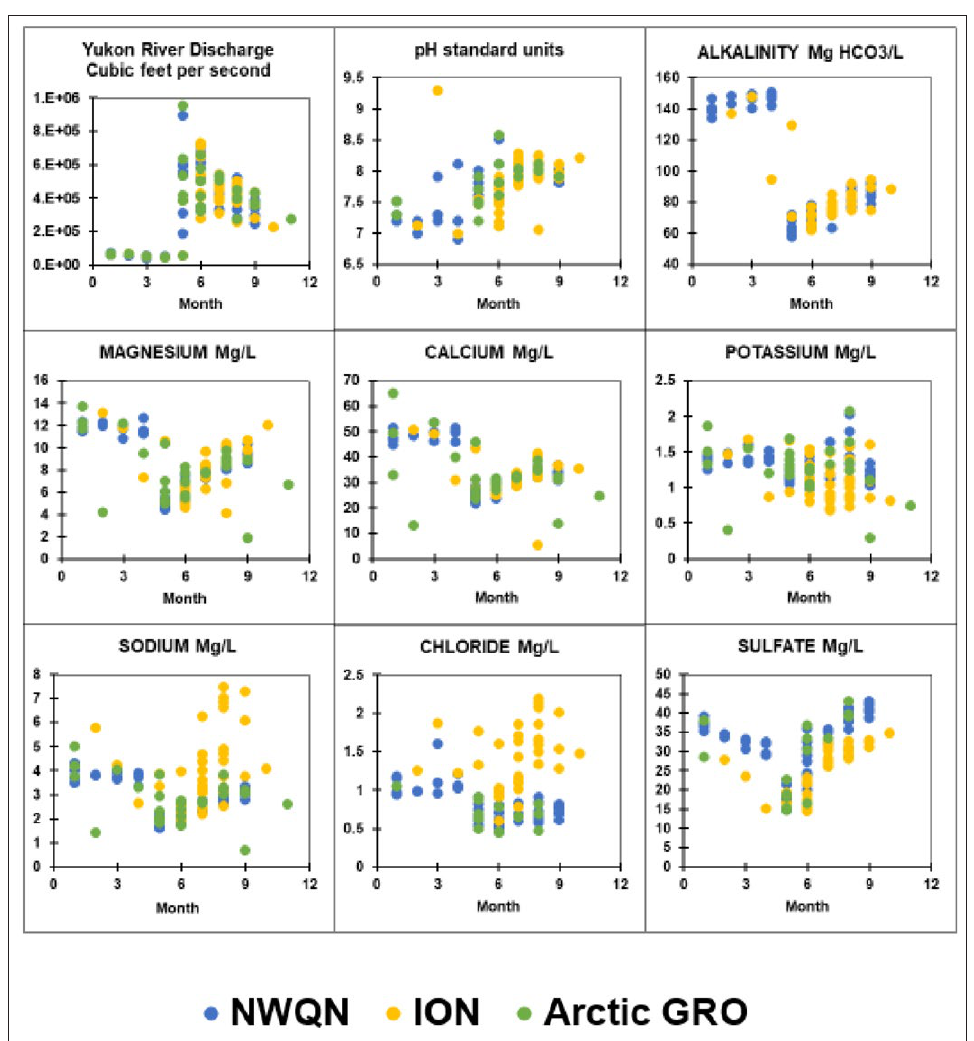
Figure 2: Instantaneous daily discharge of the Yukon River at Pilot Station corresponding to the date of sampling events and associated water quality parameter values from 2007–2014 from the National Water Quality Network (NWQN), Indigenous Observation Network (ION), and Arctic Great Rivers Observatory (Arctic GRO)